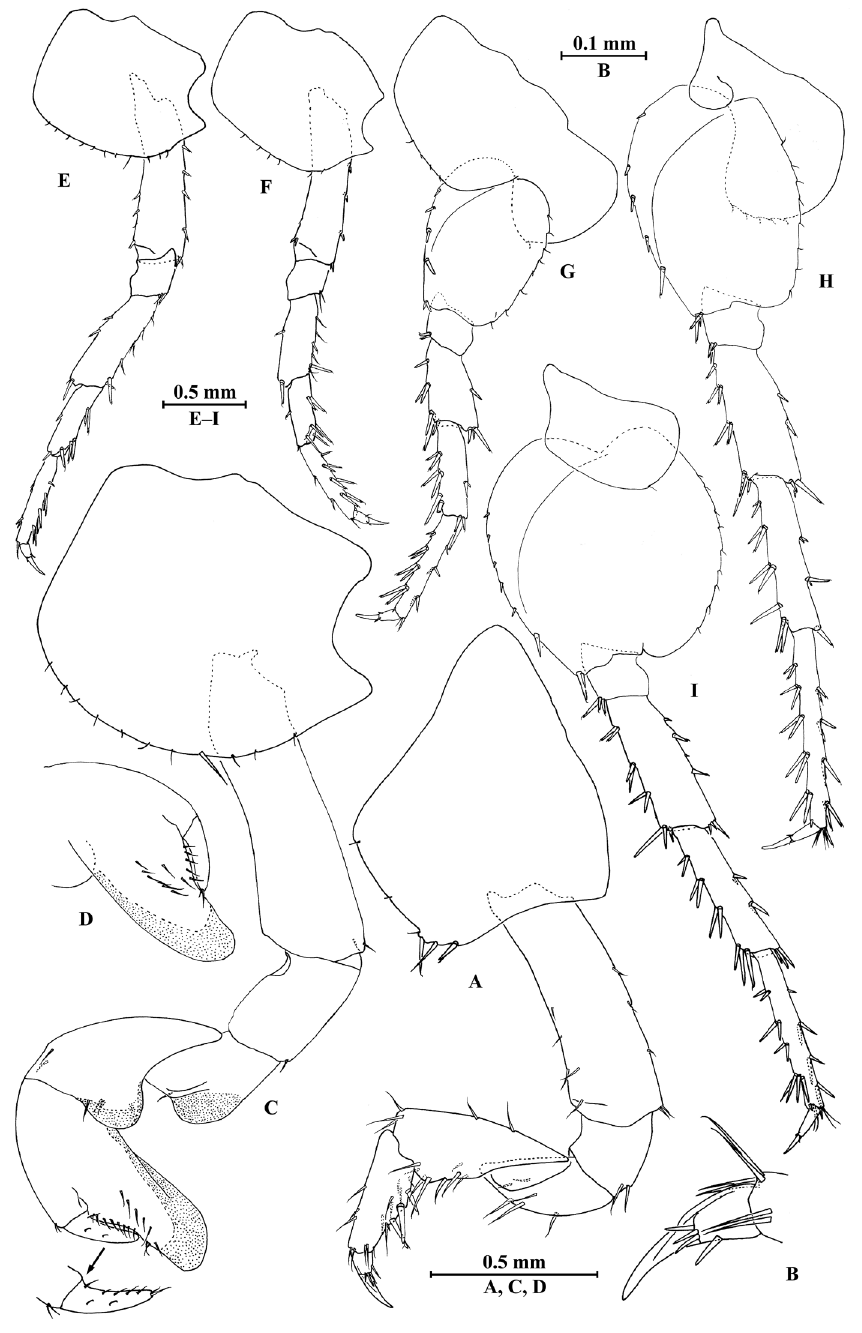
Figure 6. Myanmarorchestia peterjaegeri Hou, sp. n., male paratype. A gnathopod I B dactylus of gna- thopod I C gnathopod II D propodus of gnathopod II E pereopod III F pereopod IV G pereopod V H pereopod VI I pereopod